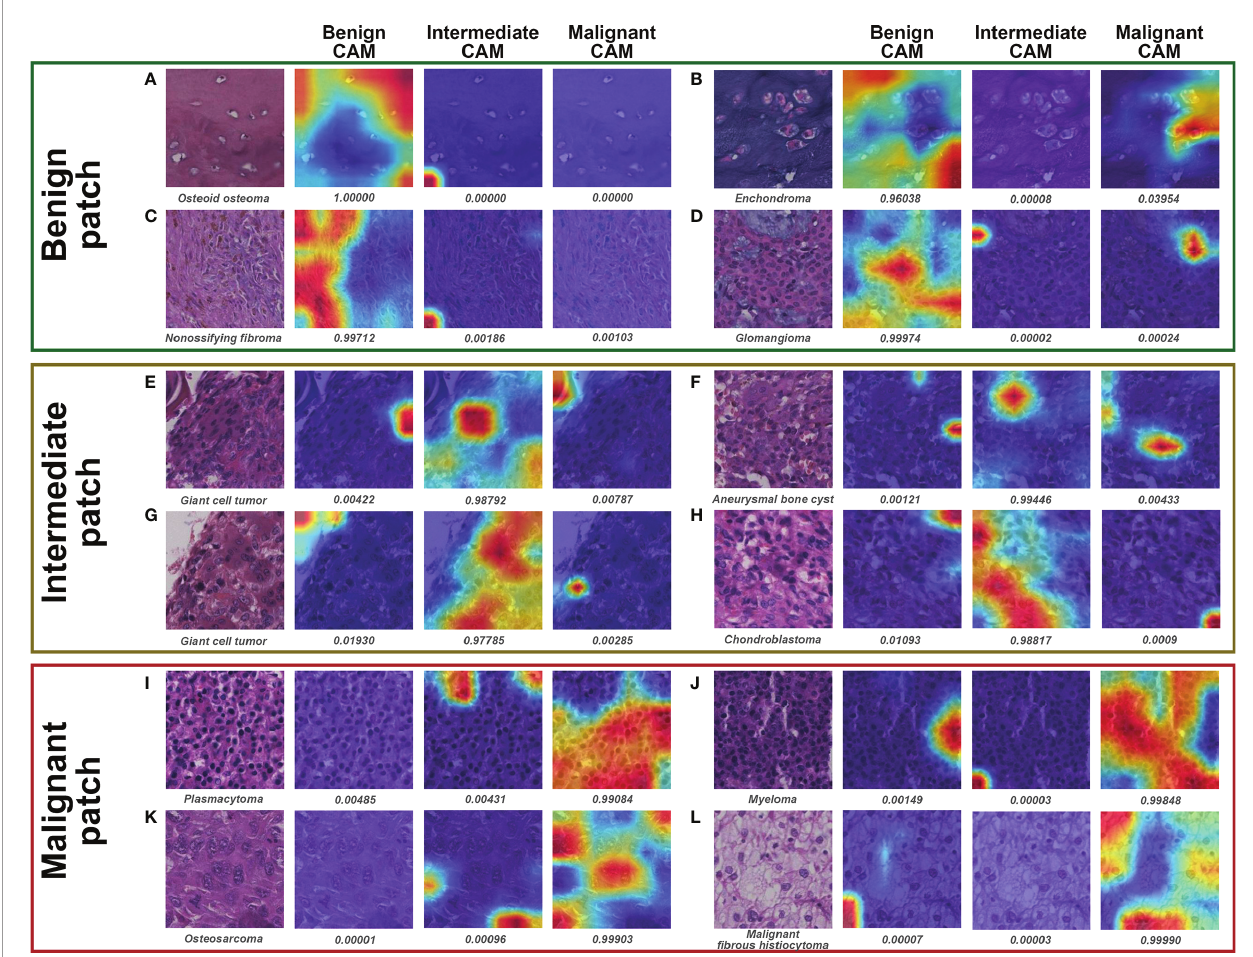
FIGURE 7 | Grad-CAM in ternary classi fi cation for representative patches of slides correctly classi fi ed by both models and pathologist #1. The speci fi c classi fi cation is shown under the original patch, and the predictive probability for CAM of each class is shown below the corresponding Grad-CAM heatmap. (A – D) , (E – H) , and (I – L) show the representative patches of benign, intermediate, and malignant bone tumors,